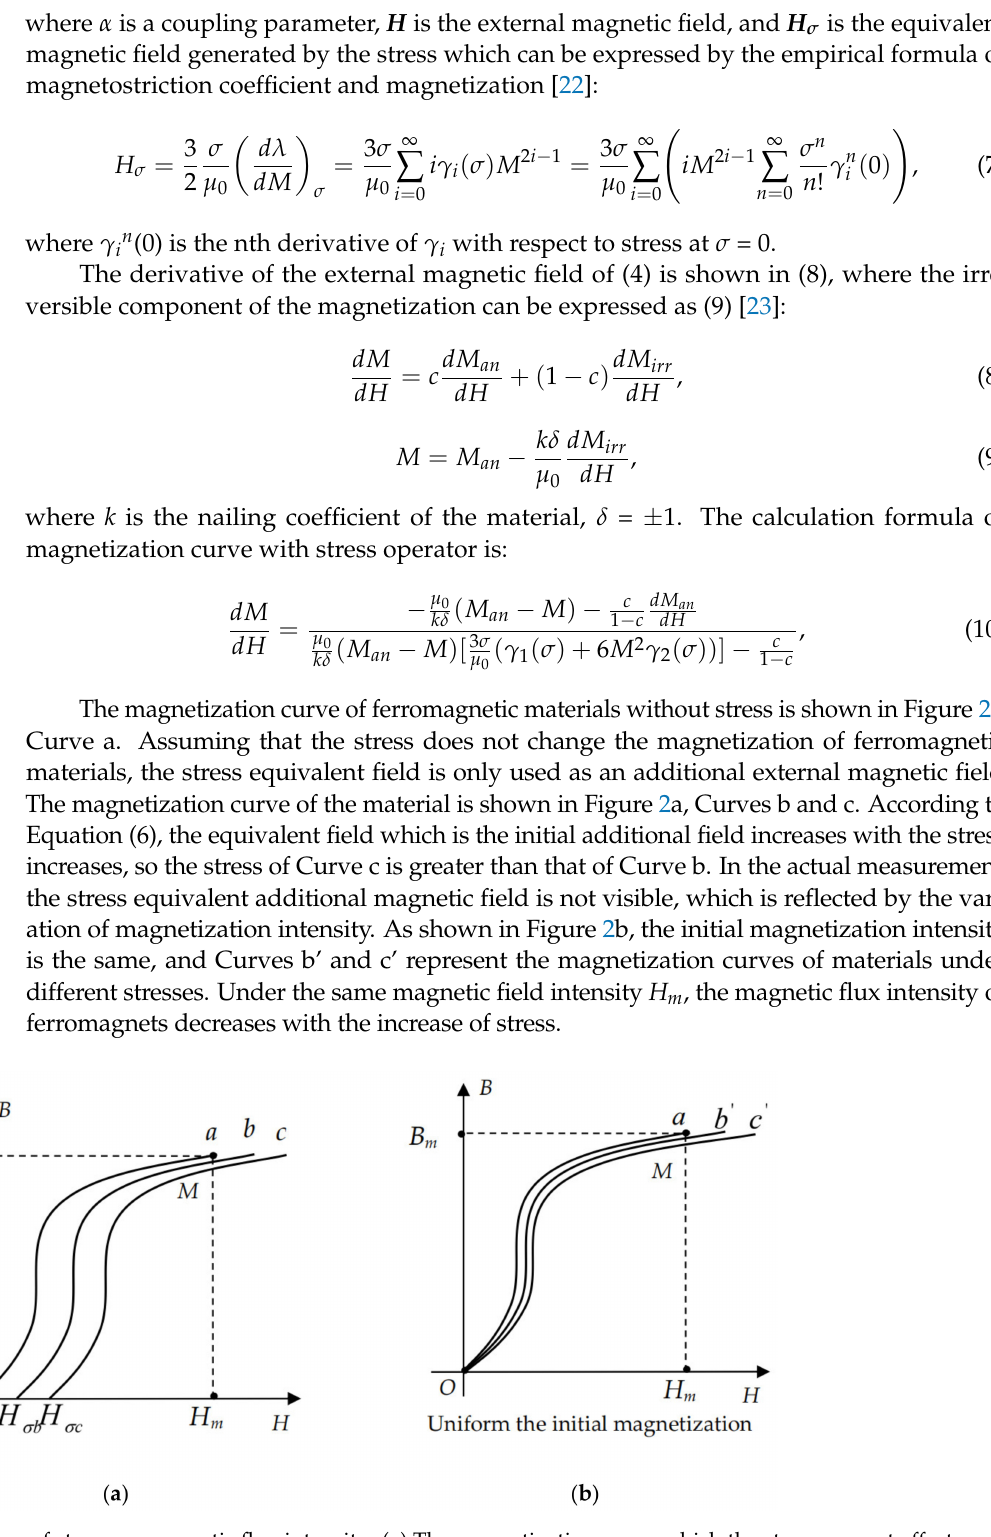
Figure 2. Influence diagram of stress on magnetic flux intensity: ( a ) The magnetization curve which the stress can not affect magnetization intensity; ( b ) The magnetization curve which the stress affect magnetization